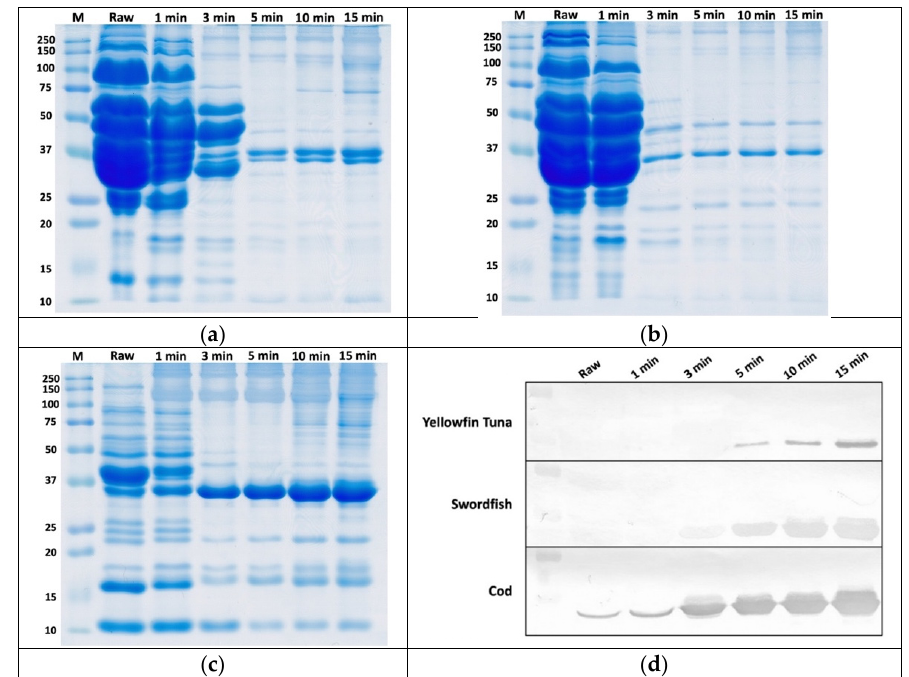
Figure 2. SDS-PAGE gel images ( a – c ) and western blot antigenic protein profiles using mAb 8F5 supernatant (1:5), ( d ) of yellowfin tuna, swordfish, and cod cooked for different lengths of time. The sample loading was 6 µ L per lane. M: Molecular weight marker.